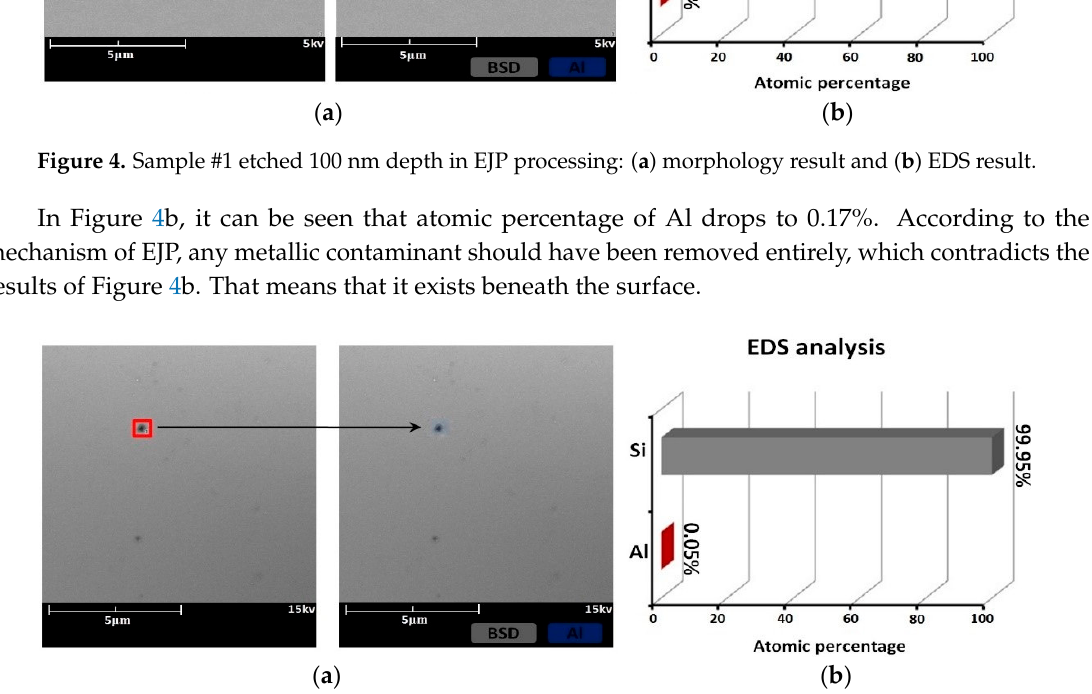
Figure 5. Sample #2 etched at 60 nm depth in SAE processing: ( a ) morphology result and ( b ) EDS result.